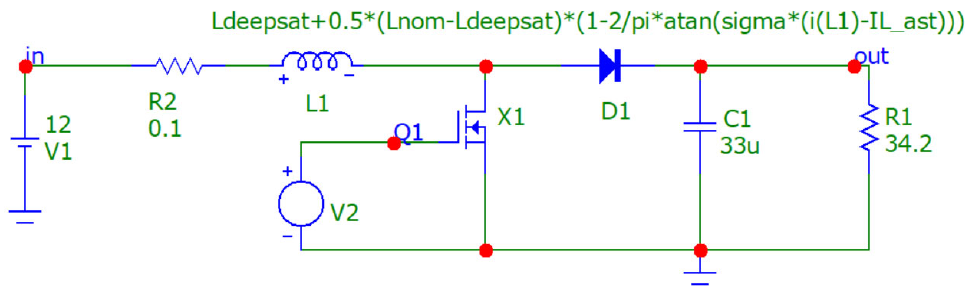
Figure 11. DC/DC boost converter implementation in Micro ‐ Cap Spice simulator with a non ‐ linear inductor using the arctan model.